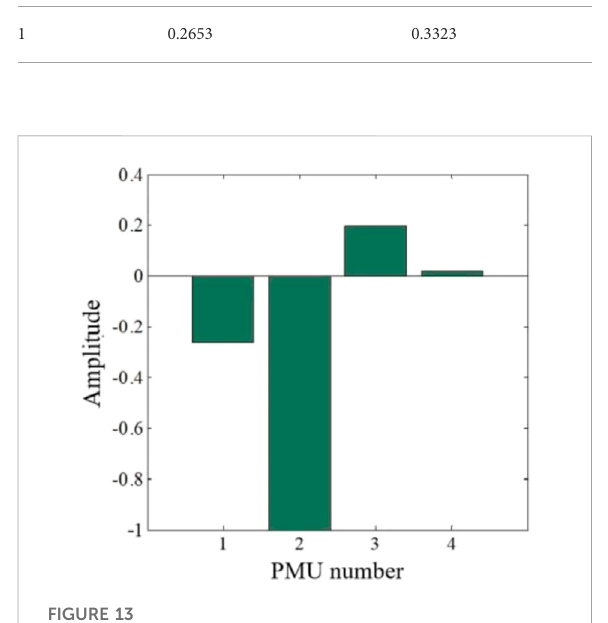
FIGURE 13 The identi fi ed mode shape of the actual power